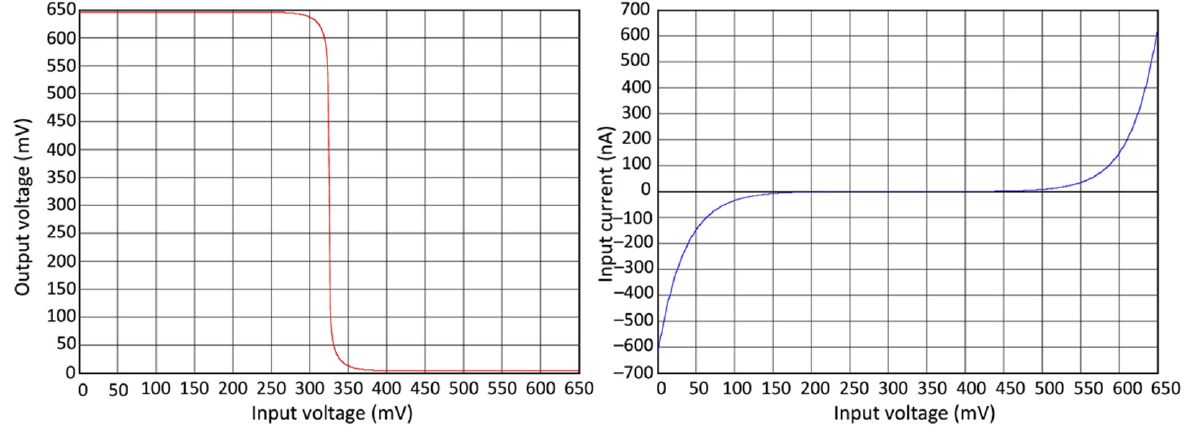
Figure 6. Transfer characteristic and input current of a CBip inverter. V CC = 0.65 V, temperature 400 K.